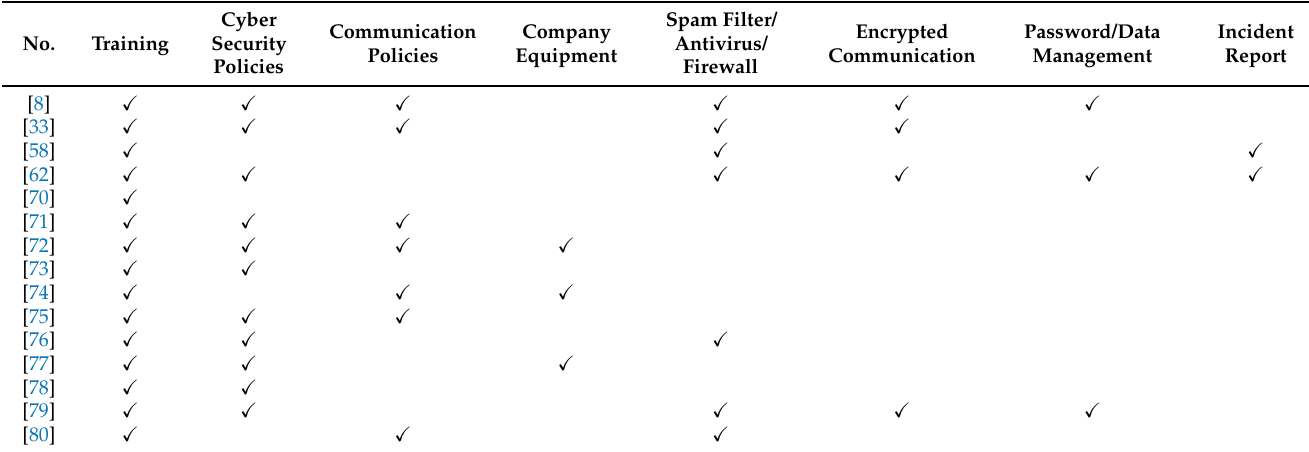
Table 9. Suggested method to counter social engineering